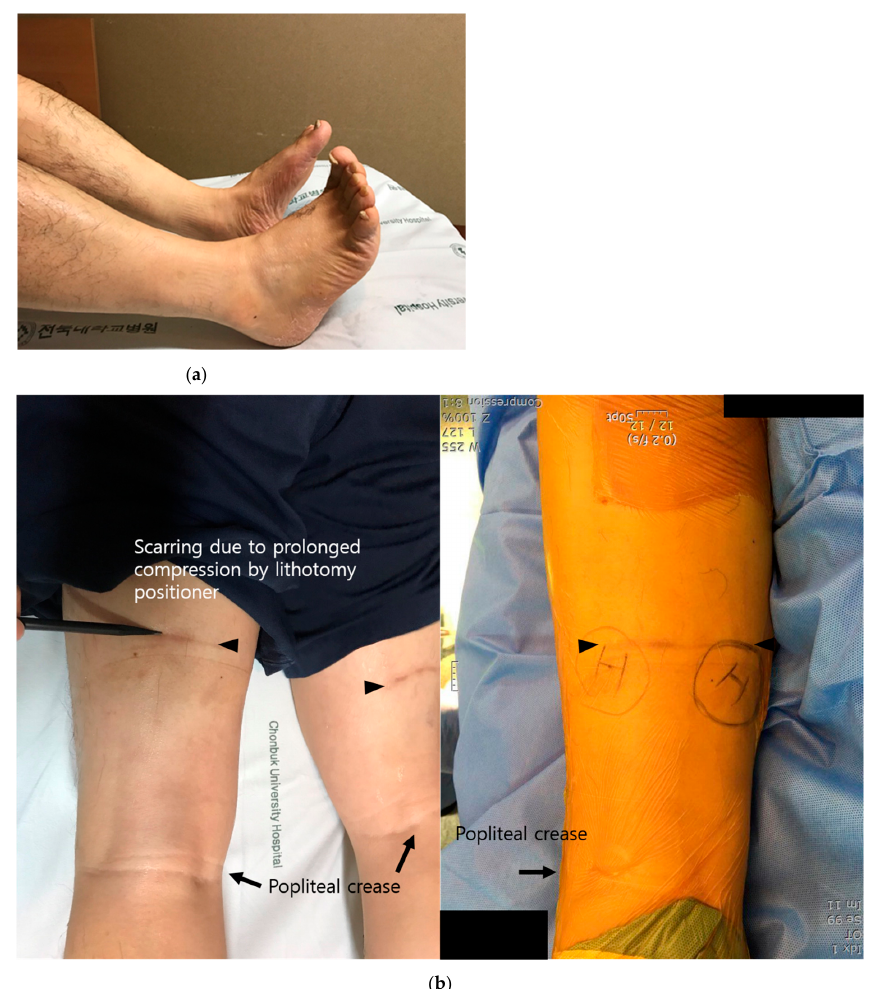
Figure 1. ( a ) 56-year-old male patient complained of abnormal sensation in the lower leg and difficulty in dorsiflexion and plantarflexion of the left ankle and toe. ( b ). Scarring (black arrowhead) due to prolonged compression by the well-leg holder is observed at the mid-thigh level, and a mass-like lesion is palpated below the line. Nerve conduction velocity/electromyography (EMG) was performed and showed a severe sciatic nerve injury at the distal thigh level. Moreover, on computed tomography (CT), ischemic changes were observed in the adductor magnus, biceps femoris long and short head, semimembranosus, and semitendinosus muscles 25 cm below the femoral head, and the length of the lesion was approximately 6 cm (Figure 2a,b). The sciatic nerve in the affected area was observed to be swollen compared to the contralateral side, and the intermuscular fat was accompanied by haziness. Ischemic changes were observed in the posterior thigh muscles on magnetic resonance imaging (MRI), similar to the previous CT scan. In addition, the sciatic nerve was severely swollen compared with the contrala- teral side, and the T2-weighted signal intensity was increased (Figure 3).